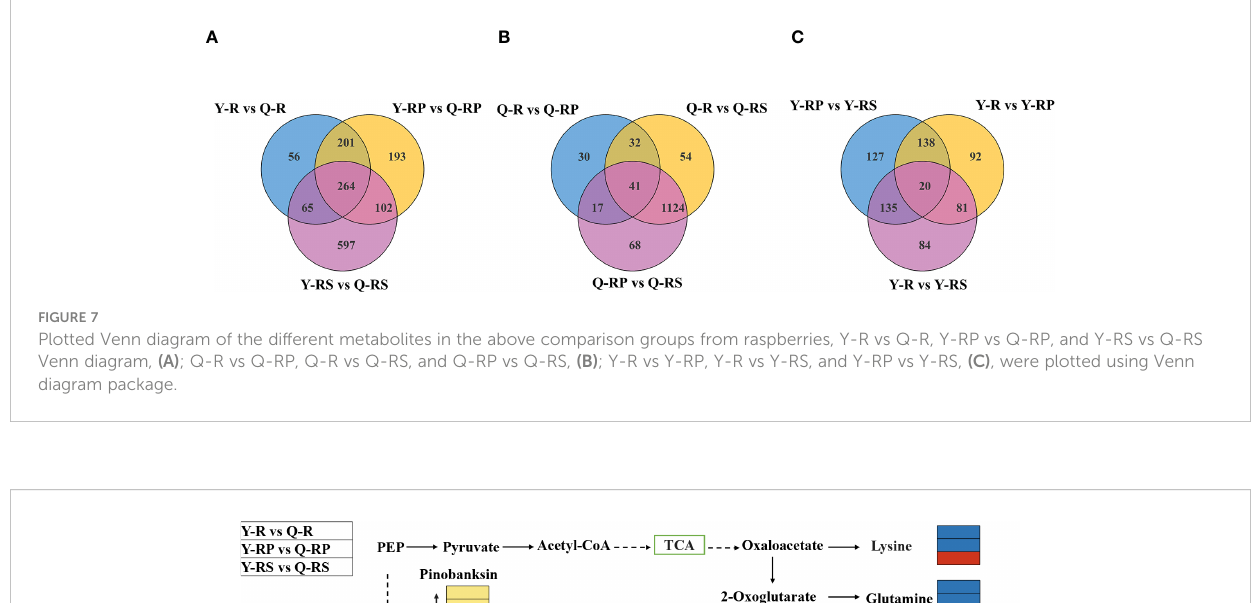
Y-RS (Figure 12C). Based on these fi ndings, it can be inferred that certain substances in the pathway of fl avonoid biosynthesis may be in fl uenced by environmental factors. As a result, the variations in